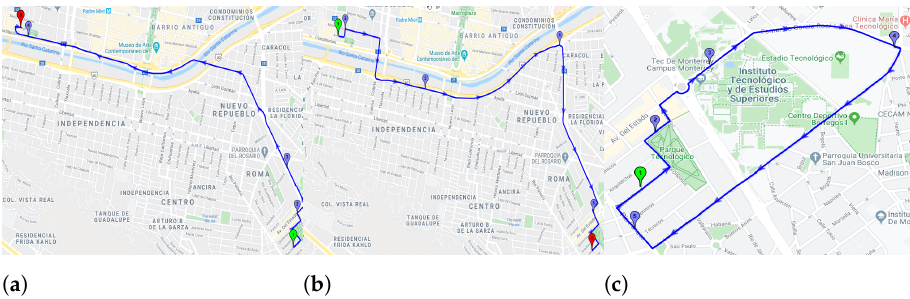
Figure 2. Routes for the experimentation: ( a ) Route 1, ( b ) Route 2, and ( c ) Route